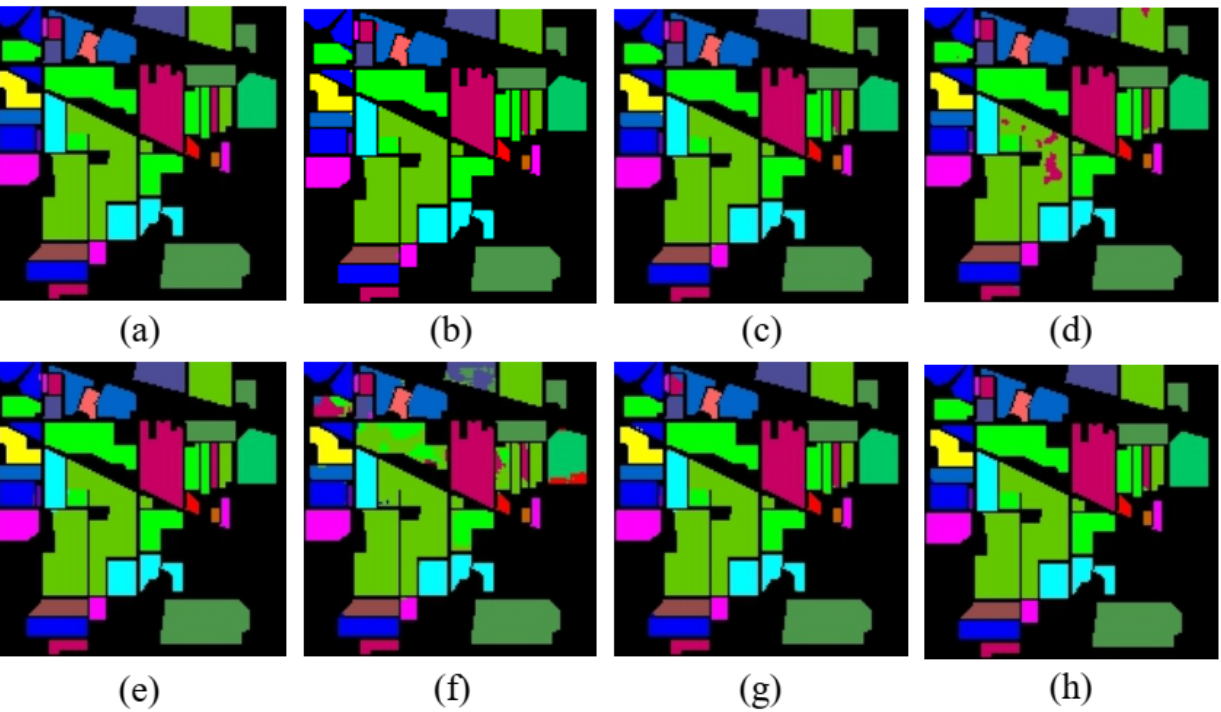
Figure 7. Classification map of various methods for IP ( a ) Ground Truth, ( b ) Resnet, ( c ) 3D-CNN, ( d ) SSRN, ( e ) HybridSN, ( f ) SPRN, ( g ) SSFTT, ( h ) SquconvNet. Table 6. Results of various methods for UP using 10% training data (Highest performance is in